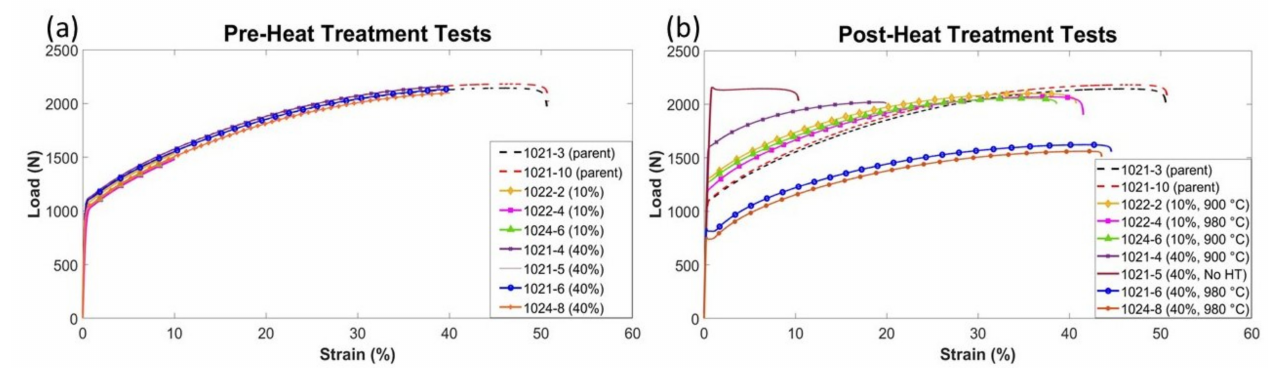
Figure 3. Stress–strain curves for ( a ) prestrain on pre-heat treatment and ( b ) tensile strength of the same specimens post-heat